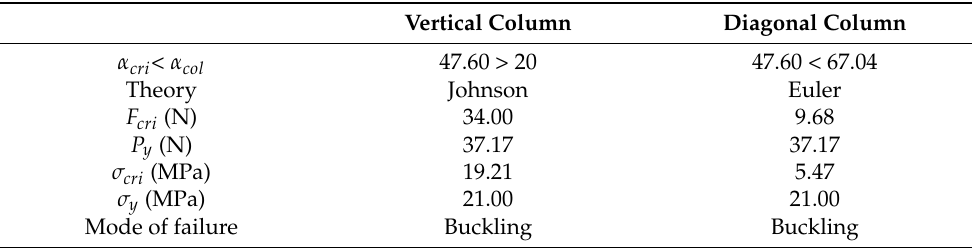
Table 1. Analytical buckling results for both column